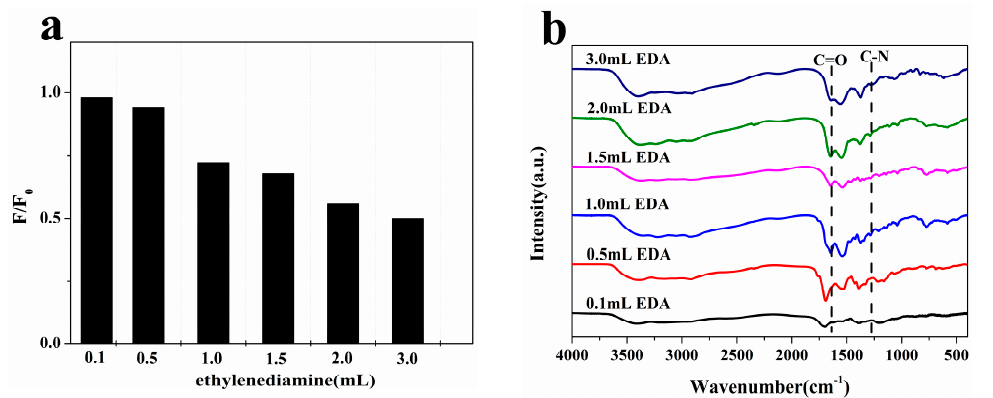
Figure 1. Effect of nitrogen source concentration on fluorescence properties of N-CQDs: ( a ) The degree of response to nitrite (10 − 5 M); ( b ) FTIR spectrum.